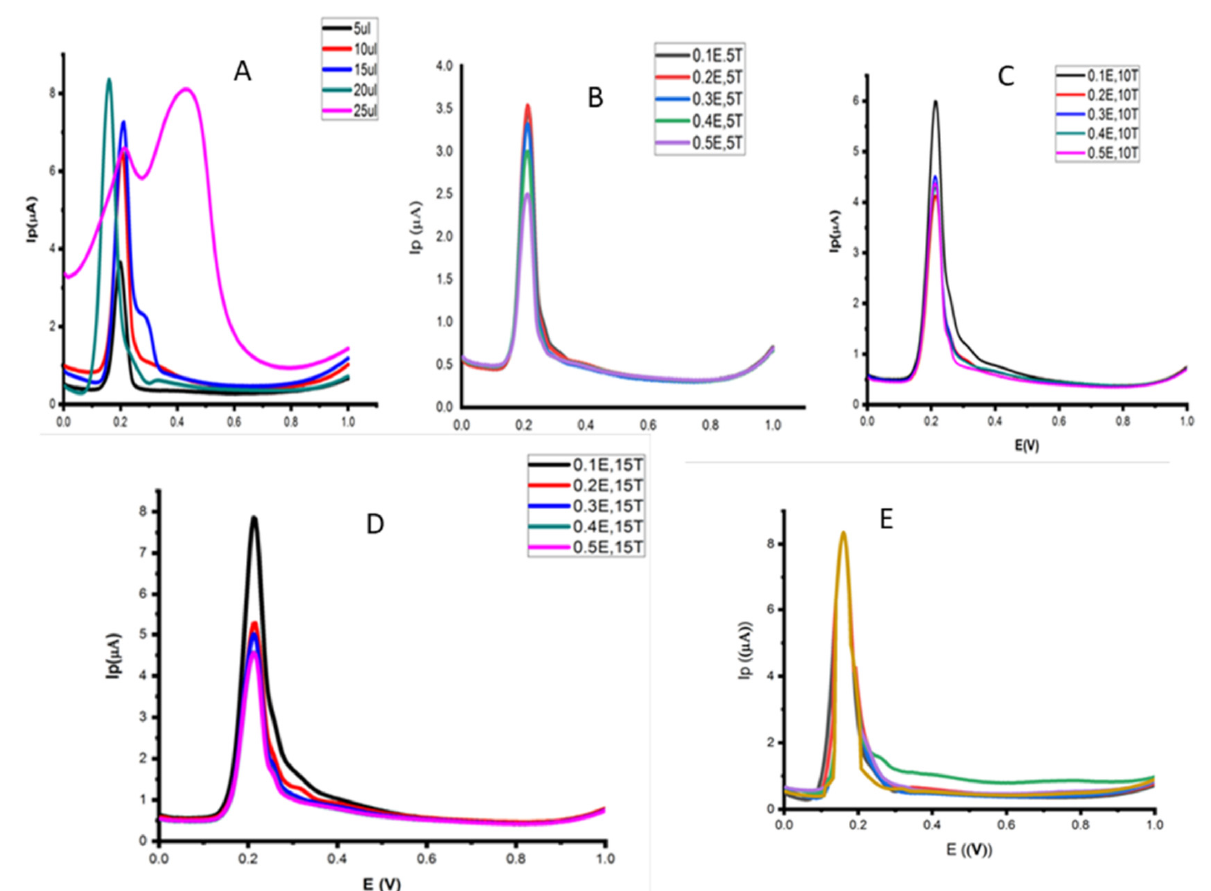
Figure 10. SW Voltammograms for 0.02 µM Hg 2+ at ( A ) Volume of Nafion from 5µL to 25 µL; ( B ) Accumulation potential 0.1 V to 0.5 V at 5 s; ( C ) Accumulation potential 0.1 V to 0.5 V at 10 s; ( D ) Accumulation potential 0.1 V to 0.5 V at 15; ( E ) Six replicate runs obtained under optimized condi- tions.